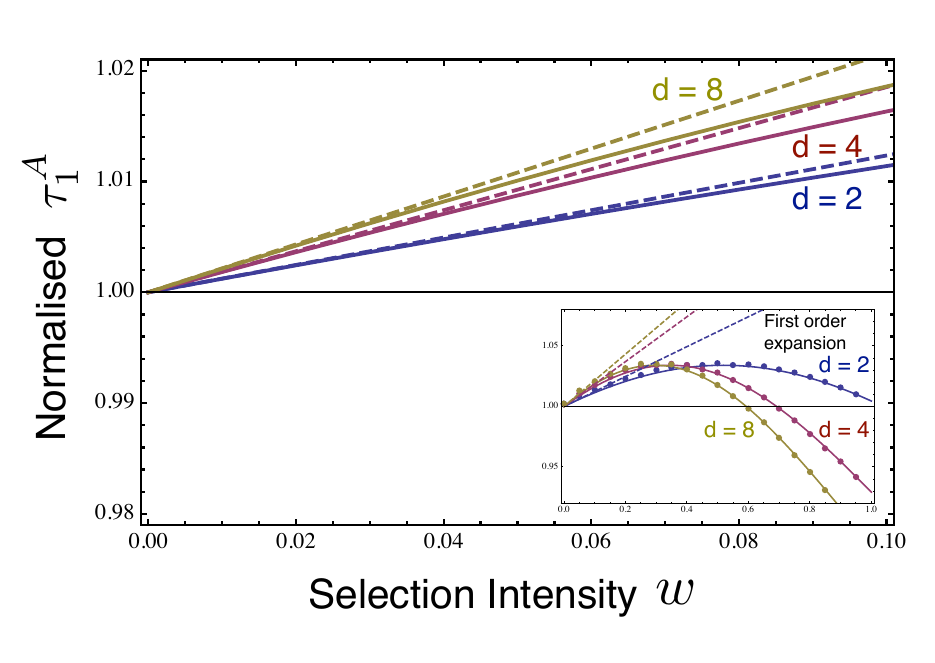
Figure 2. Stochastic slowdown is enhanced in multi-player games. The figure shows the fixation time conditioned on fixation for a game in which strategy A never has a selective = 2 − ( k + 1) /d and b = 1 . The main figure shows the normalized disadvantage, a k k conditional fixation times (solid lines) and the first order approximations (dashed lines) for games with d = 2 , d = 4 , and d = 8 player games. The inset shows the same for higher intensities of selection elucidating the hump shape of the function that becomes more pronounced as the number of players increases (population size N = 10